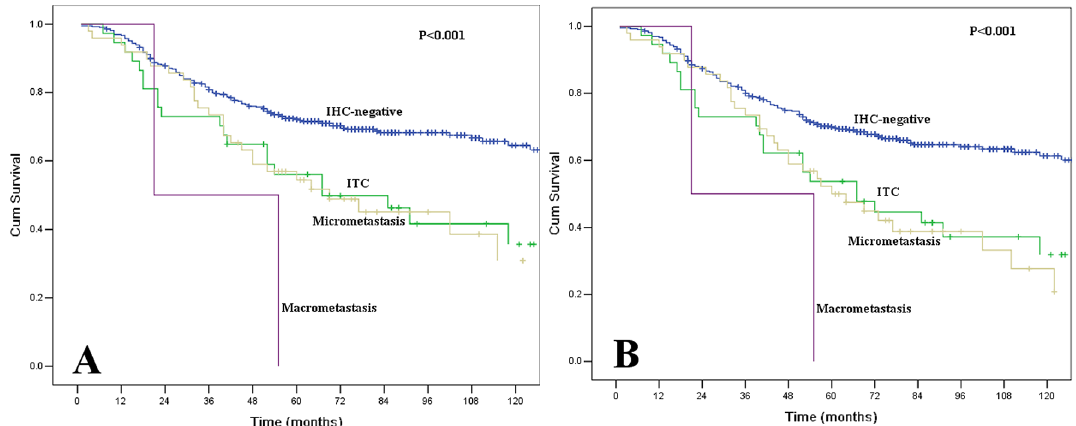
Figure 5. ( A ) Comparisons of overall survival between different tumor deposit groups. The survival was significantly different across these four groups (P < 0.001). ( B ) Comparisons of disease-free survival between different tumor deposit groups. The survival was significantly different across these four groups (P < 0.001).